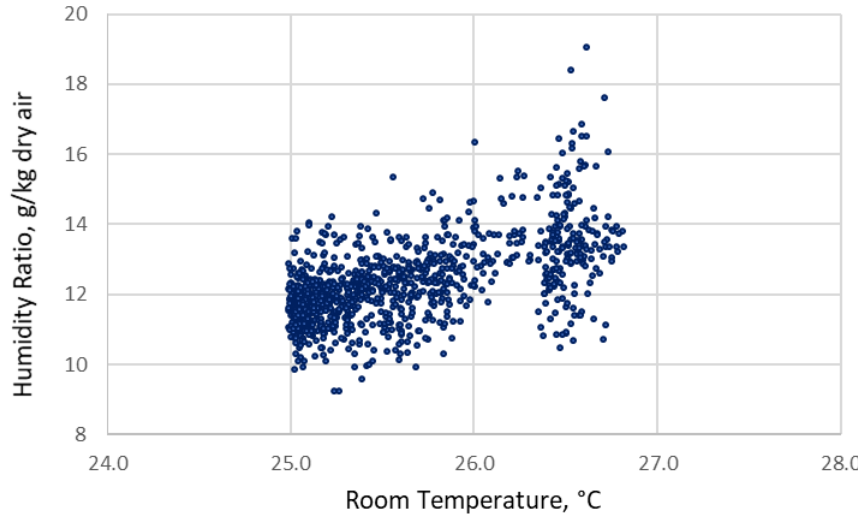
Figure 12. Temperature vs.humidity ratio—living room.